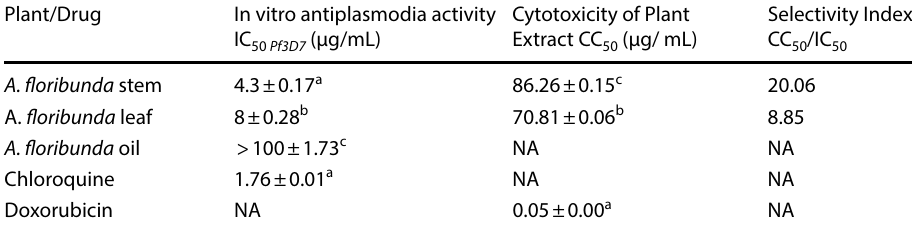
, CC values 50 50